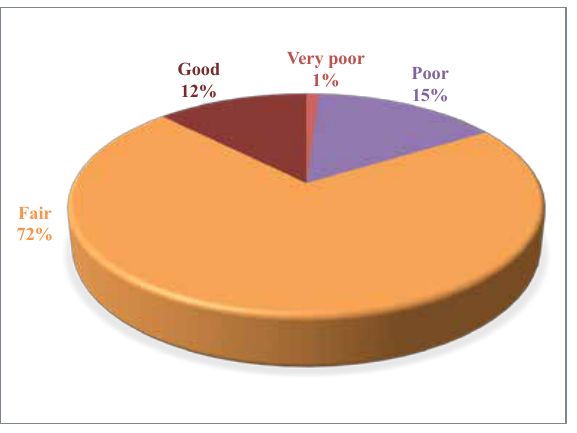
Table V. % Distribution of websites by DISCERN category (N = 105).